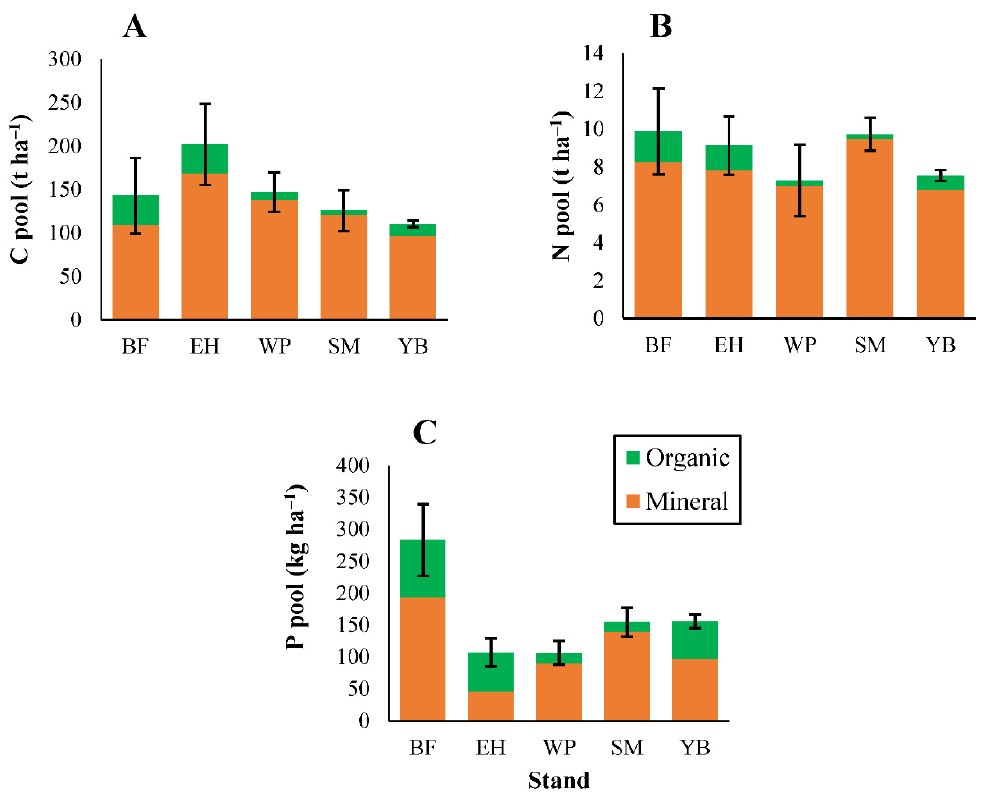
Figure 4. Organic and mineral horizon soil pools of carbon ( A ), nitrogen ( B ), and phosphorus ( C ). ANOVA test results shown in Table S3 (no significant differences in the combined organic/mineral pools were present among stands for these elements). Error bars indicate S. E. For BF, EH, and YB, n = 3. For SM and WP, n = 5.